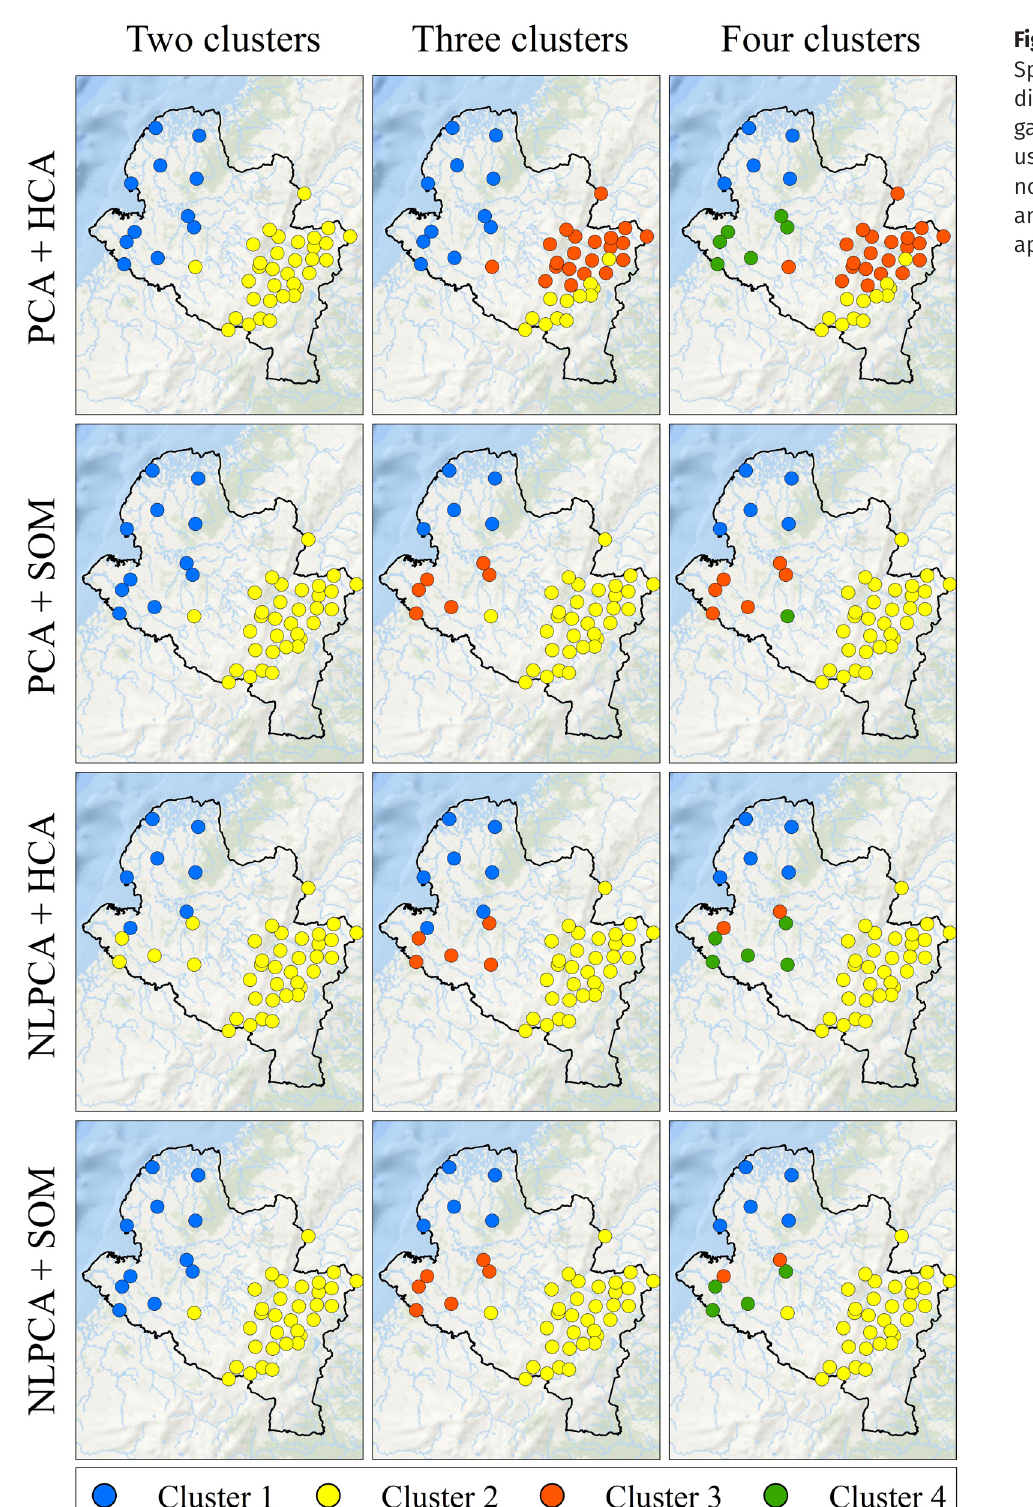
Figure 6. Spatial distribution of gauge stations using linear, non-linear and hybrid